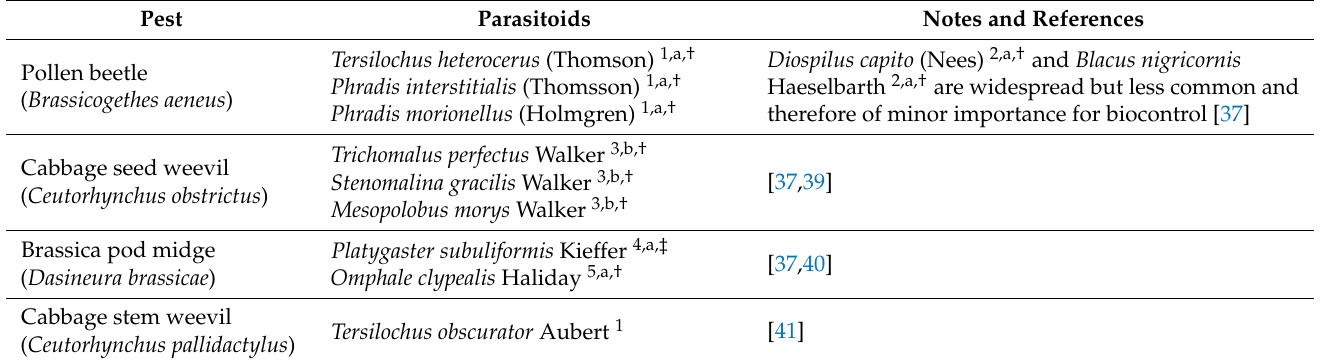
Table 1. The main Hymenopteran parasitoid species specialising on insect pests of oilseed rape in the study